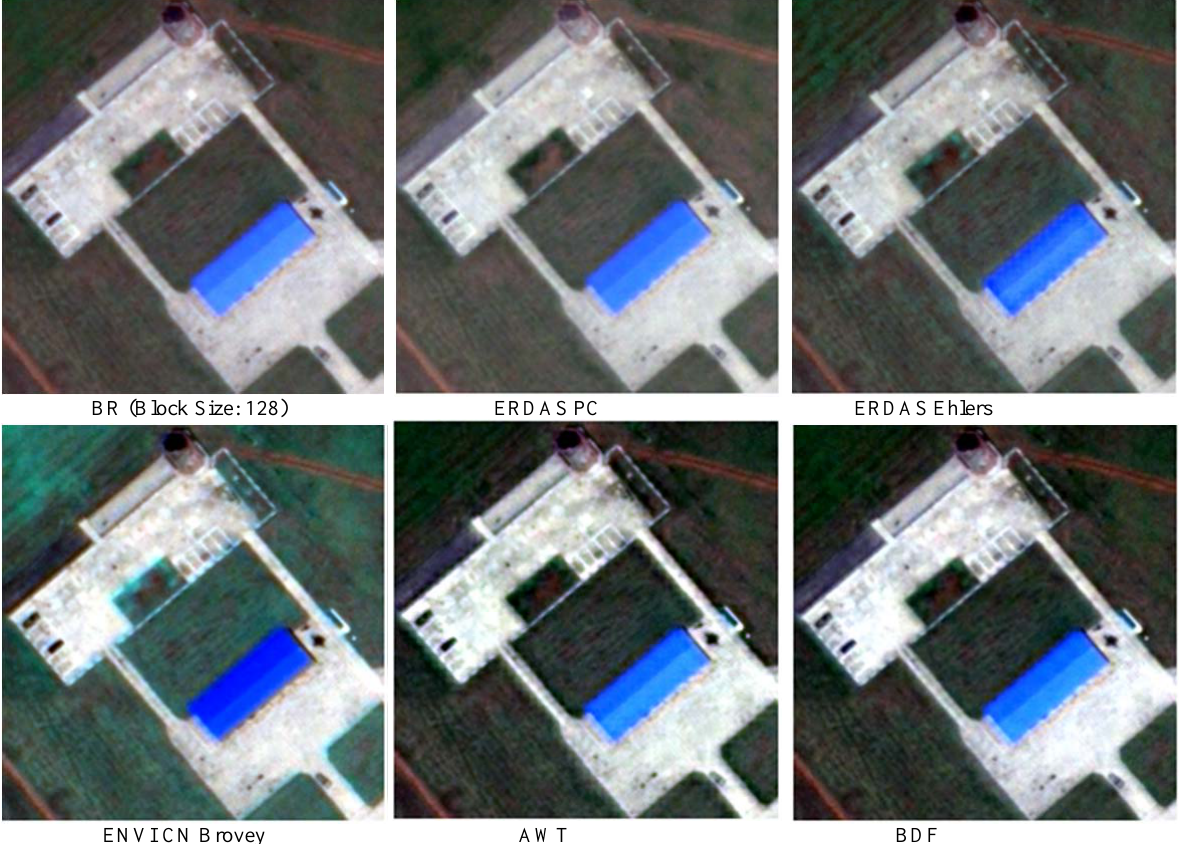
Figure 3. Pan-sharpened Worldview-2 images using different pan-sharpening algorithms